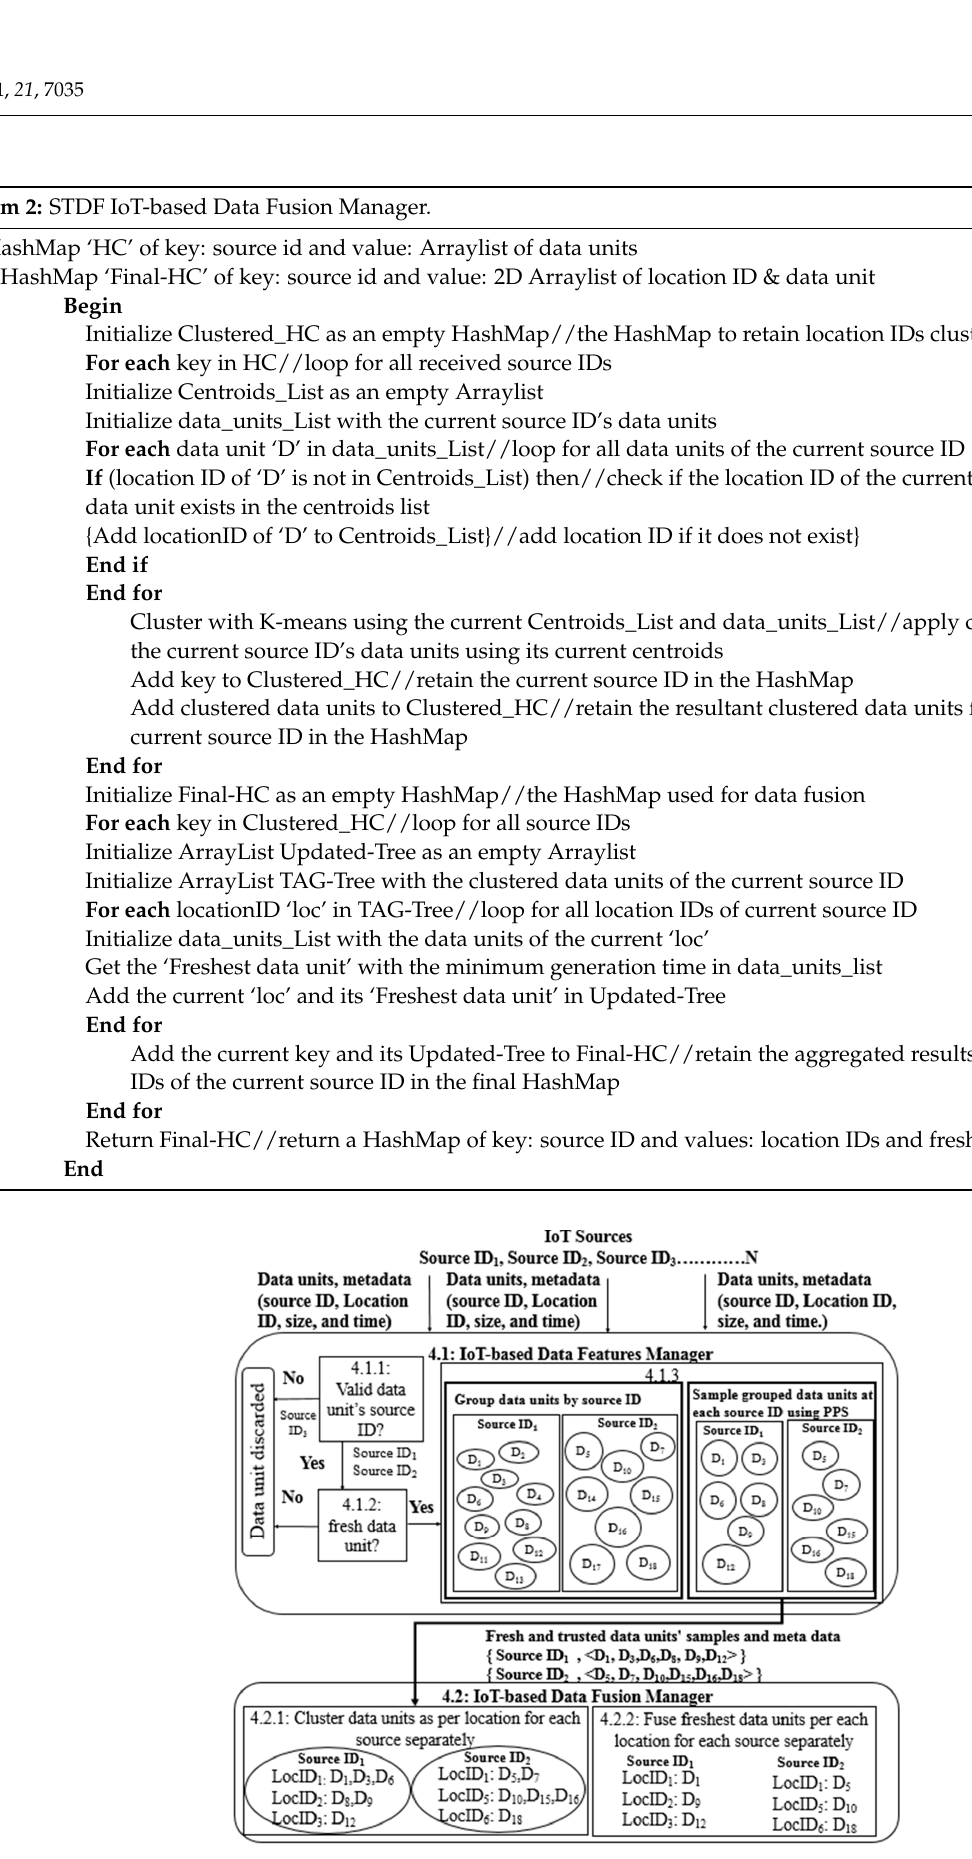
Figure 5. The proposed STDF processing scenario.